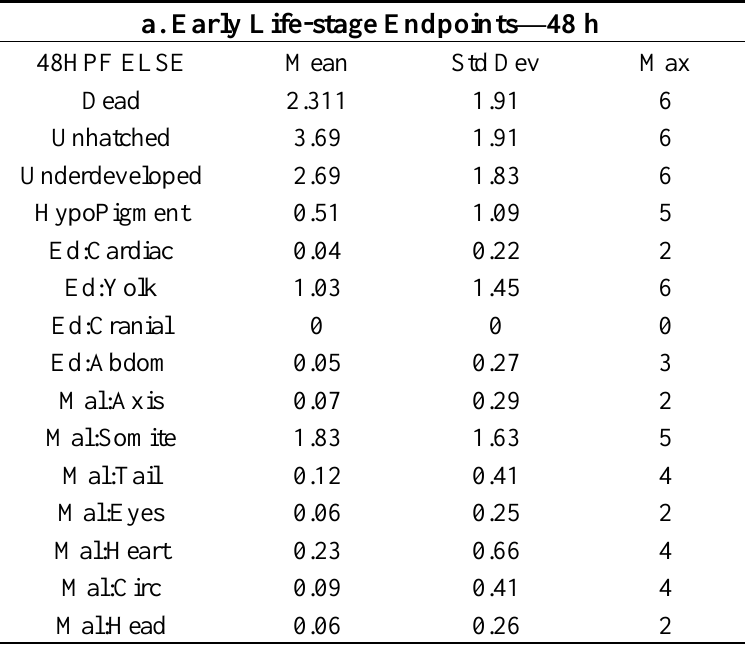
Table 1. Treatment summary statistics of early life-stage endpoints: death, hatch, development, lack of pigmentation, cardiac edema, yolk edema, cranial edema, abdominal edema, malformation of body axis, somite development, tail malformation, eye malformation, heart/heartbeat malformation, circulatory malformation, and head malformation. Replicates consisted of six embryos yielding a maximum possible response of six. ( a ) 48 h post-fertilization, ( b ) 72 h